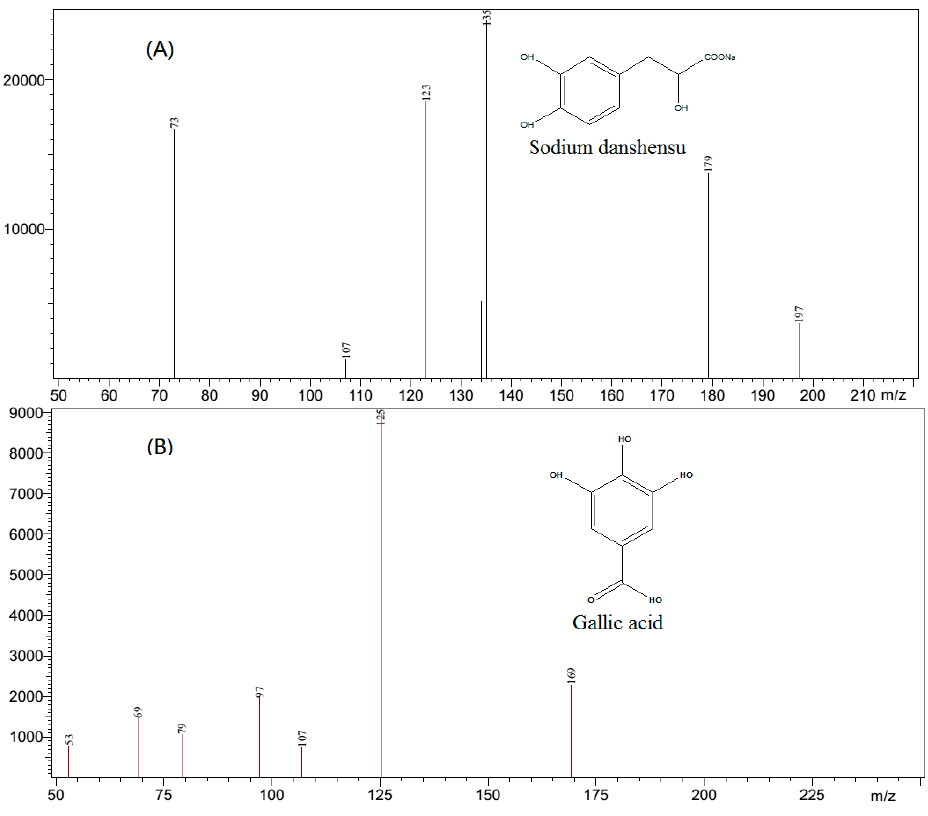
Figure 2. Representative product ion mass spectra of ( A ) Sodium danshensu ( B ) Gallic acid (IS).